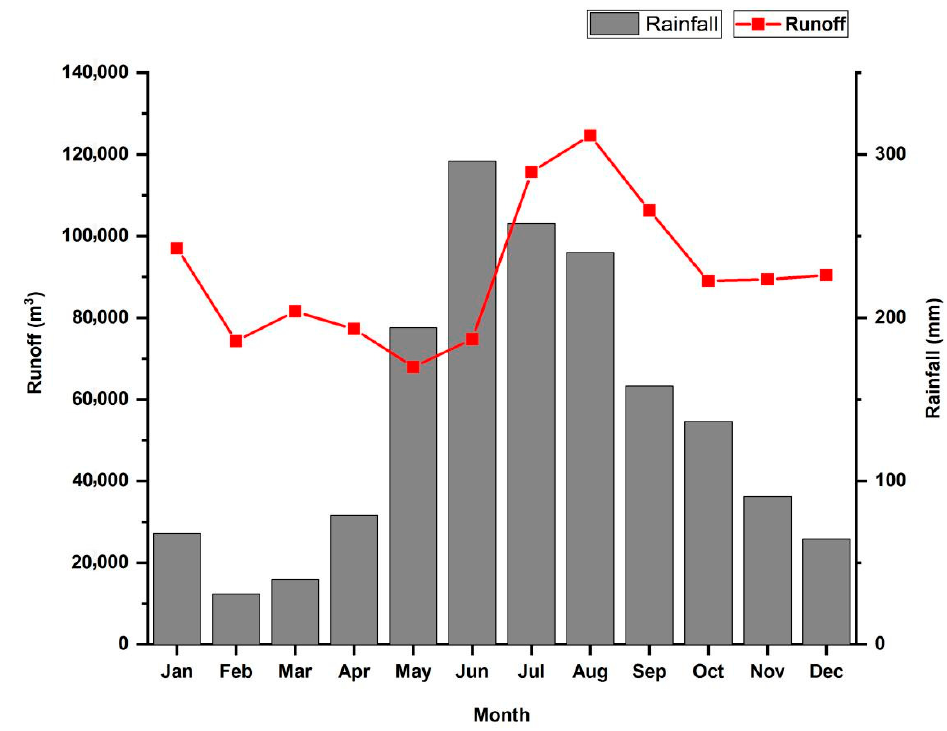
Figure 5. Monthly average precipitation and runoff from 2012 to 2016.